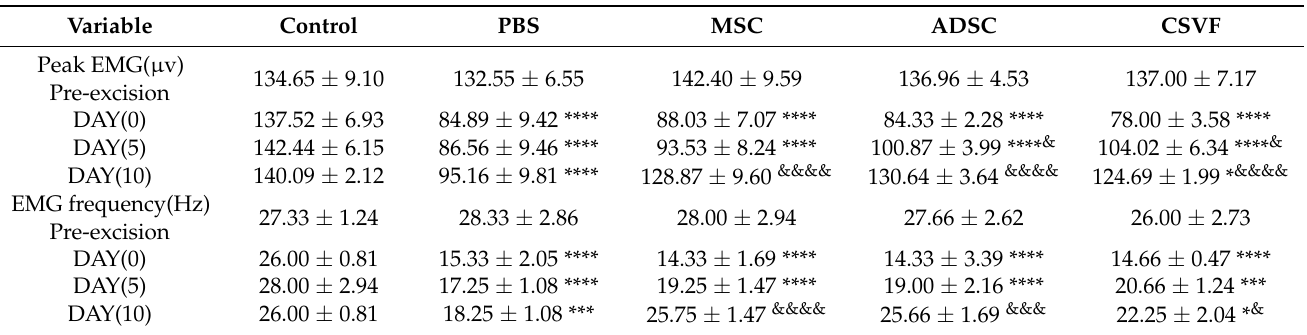
Table 2. Peak and frequency EMG plots of the control group, PBS group, MSC group, ADSC group and CSVF